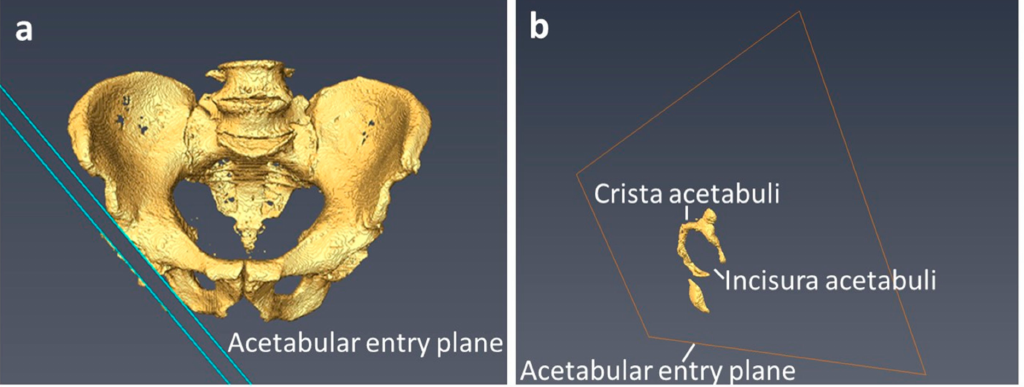
Figure 2. Acetabular entry plane: ( a ) Visualizes the acetabular entry plane with the bony irregularities of the crista acetabuli slightly laterally displaced for better illustration. The acetabular entry plane defines the acetabular orientation and reproduces the crista acetabuli as accurately as possible. ( b ) Shows the crista acetabuli in relation to the acetabular entry plane, which has been moved toward the acetabular fossa for better visualization.